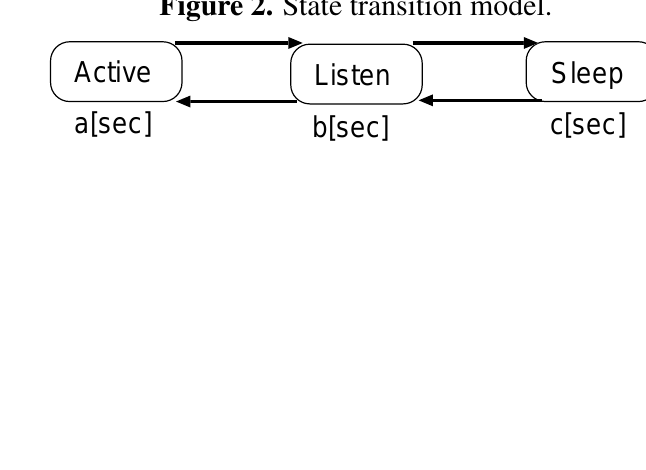
Figure 1. Sensor model. Figure 2. State transition